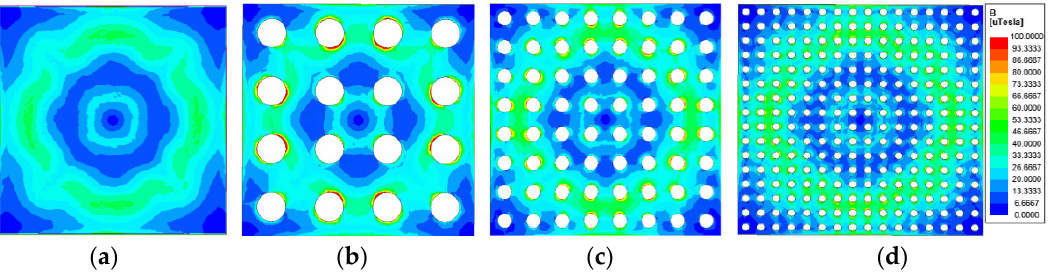
Figure 6. Magnetic field distribution of aluminium plate with different mesh array structure: ( a ) solid aluminium plate; ( b ) 4 × 4; ( c ) 8 × 8; ( d ) 16 × 16.